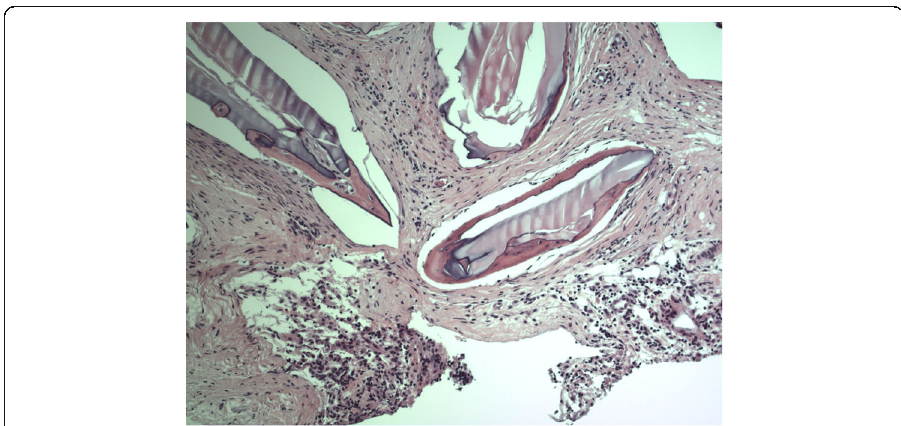
Fig. 4 Histological specimen taken from an obliterated mastoid in a patient who underwent revision surgery for cholesteatoma showing osteoblast ingrowth between S53P4 glass granules indicating formation of new